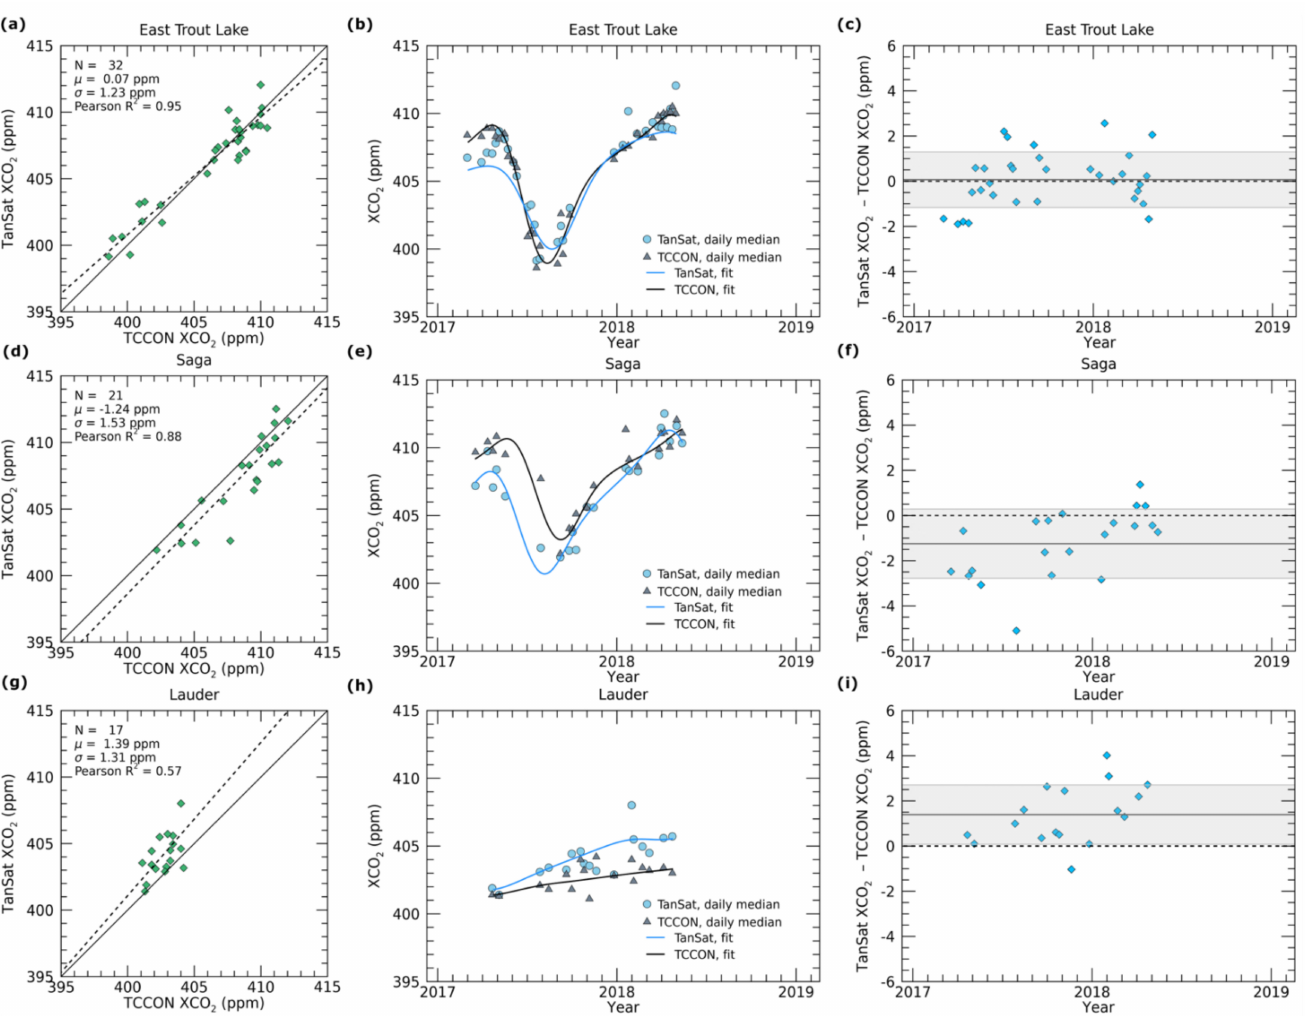
Figure 5. Evaluation of TanSat OCFP against the TCCON at East Trout Lake, Canada ( a – c ), Saga, Japan ( d – f ), and Lauder, New Zealand ( g – i ). Left columns present 1:1 comparison of the daily median XCO 2 and a linear fit (dashed line); middle columns show XCO 2 time series of the TCCON and TanSat (symbols) and an optimised seasonal cycle fit (solid lines); right columns present the time series of the bias determined as TanSat XCO 2 —TCCON XCO 2 . The grey areas depict the 1 σ deviation from the mean